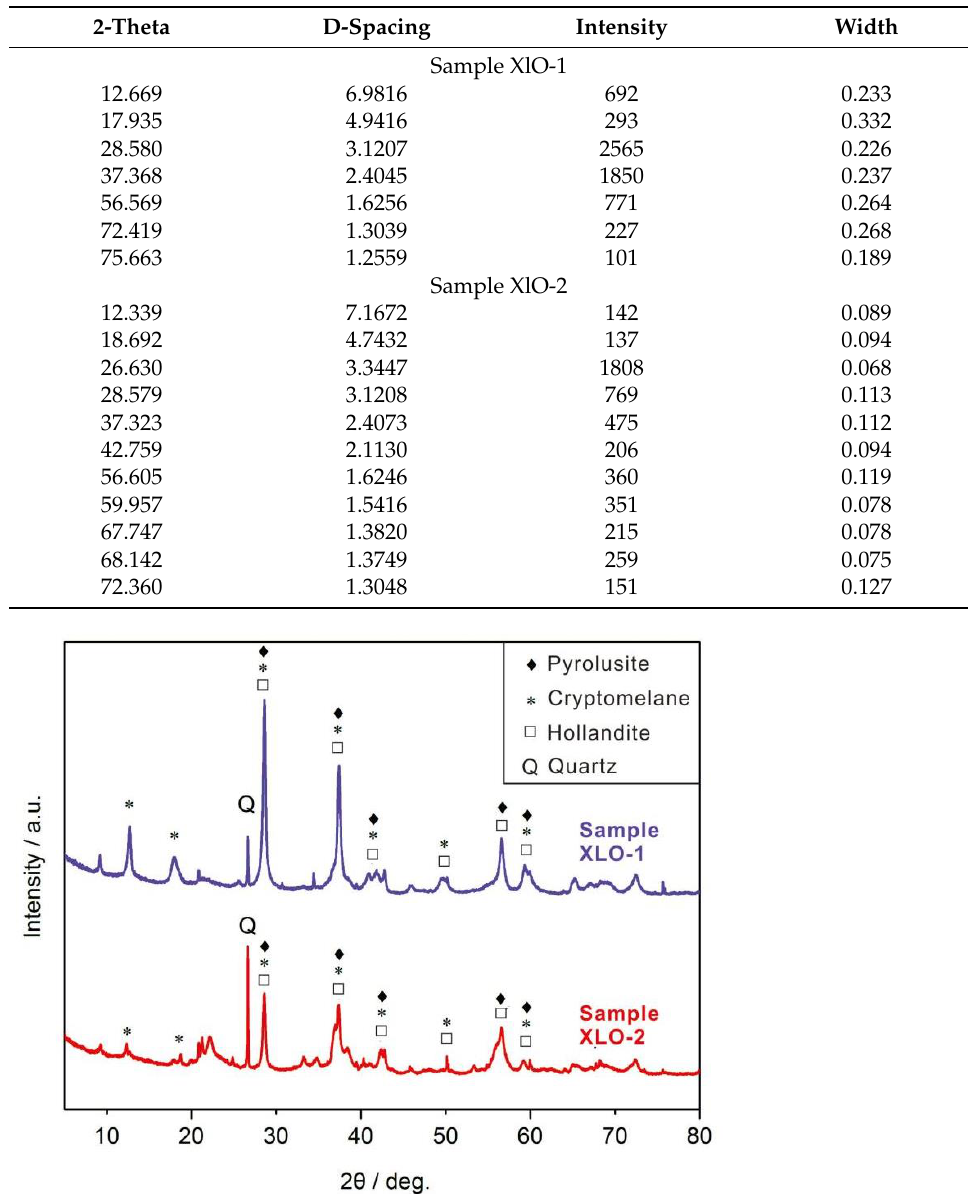
Table 2. XRD peak lists of the Mn oxide in the Xialei deposit.